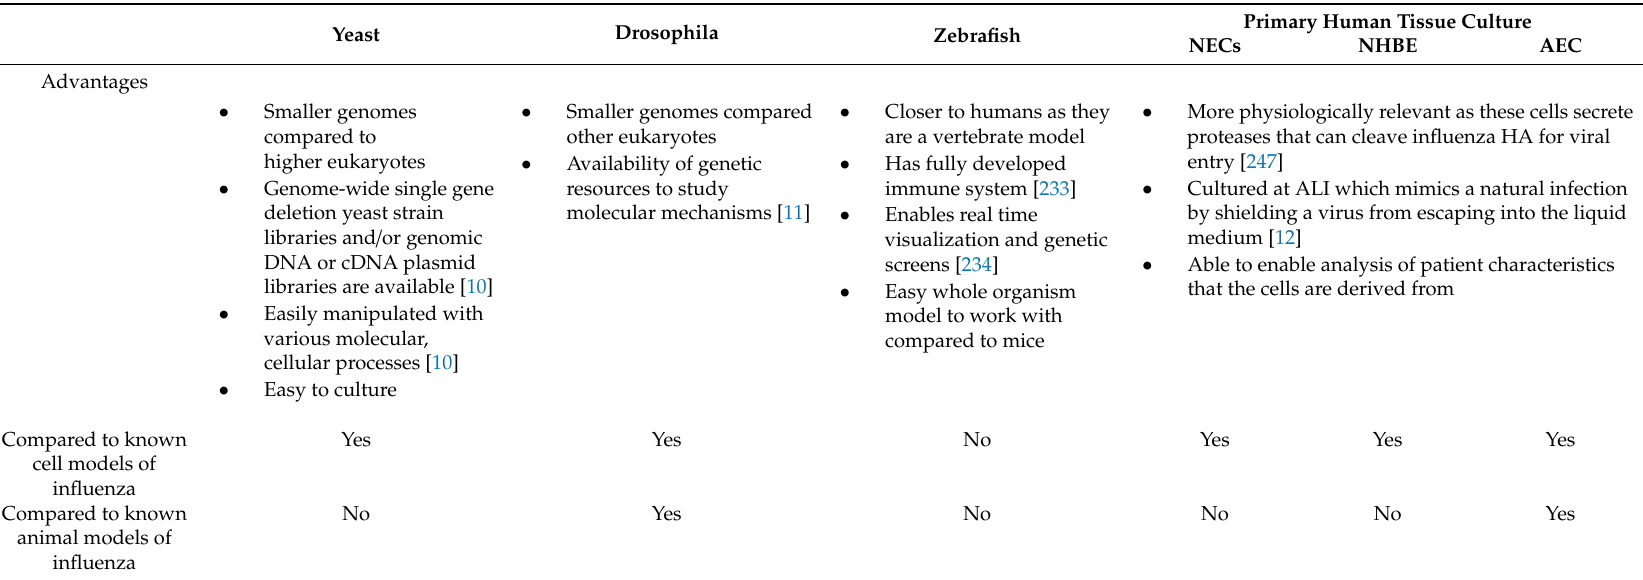
Table 1. Comparison of the various novel methods of